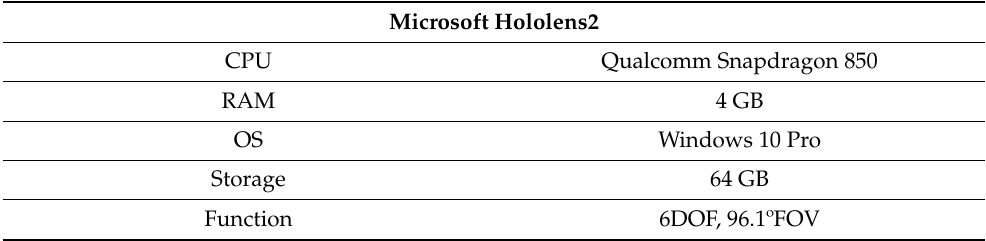
Table 2. Mixed reality device